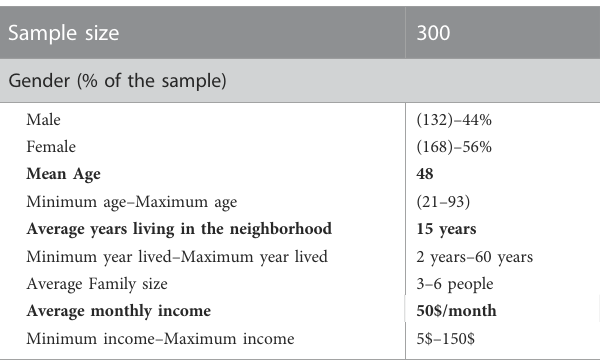
TABLE 4 Summary of the survey subjects of residential occupants in the study